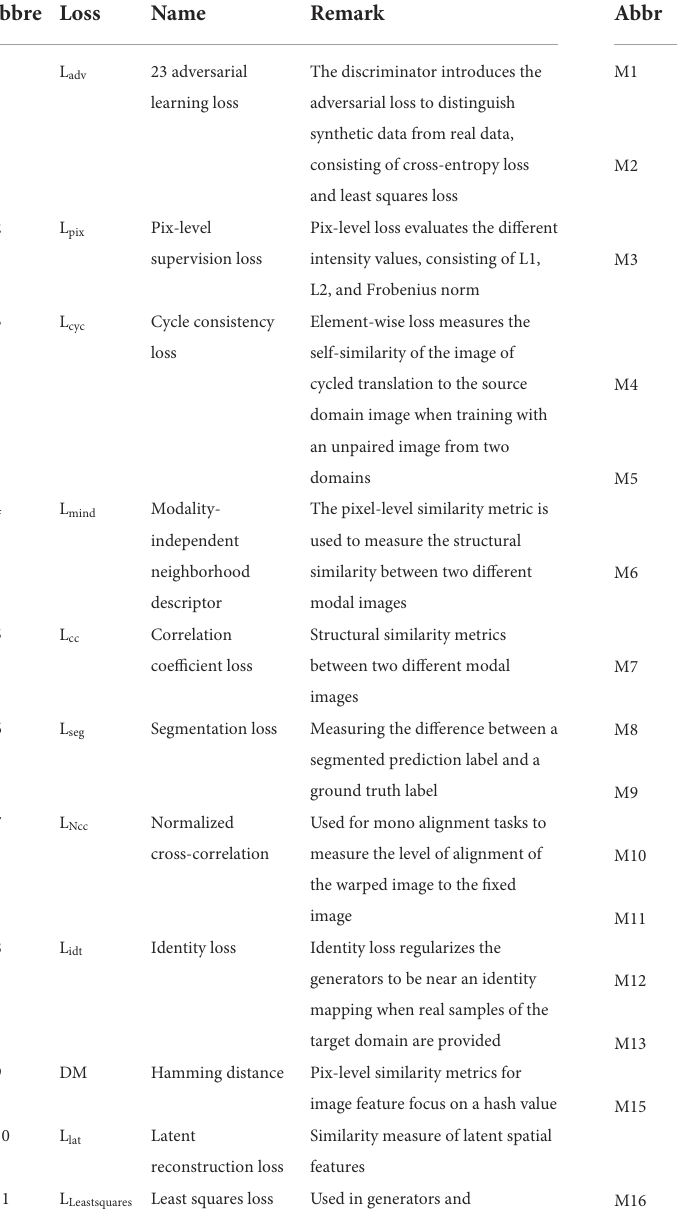
TABLE 6 A brief summary of different losses used in the reviewed publications in Tables